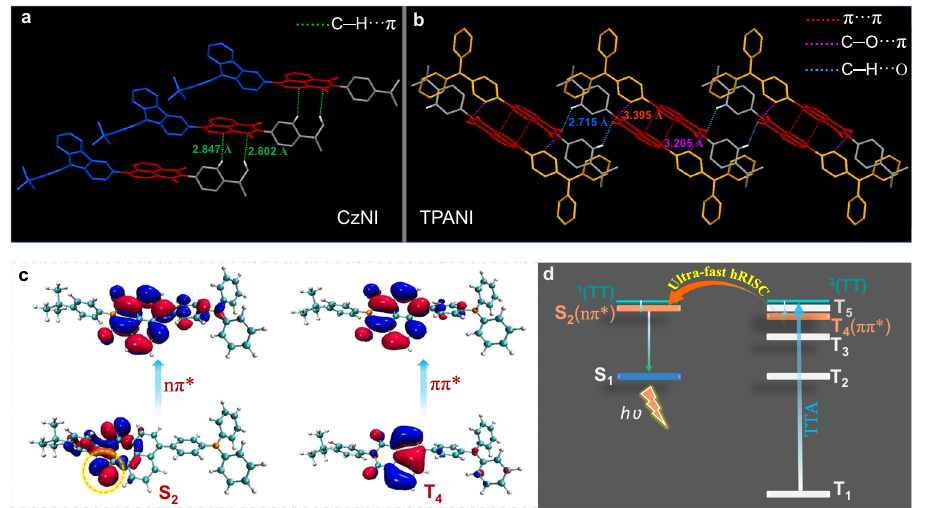
Fig.5|Molecularpackingandtheoreticalcalculationresults.a , b MolecularpackingpatterninsinglecrystalsamplesofCzNIandTPANI. c NTOpairsofTPANIfortheS 2 and T 4 states. d Proposed mechanism for the n π *-involved TTA- m -hRISC in